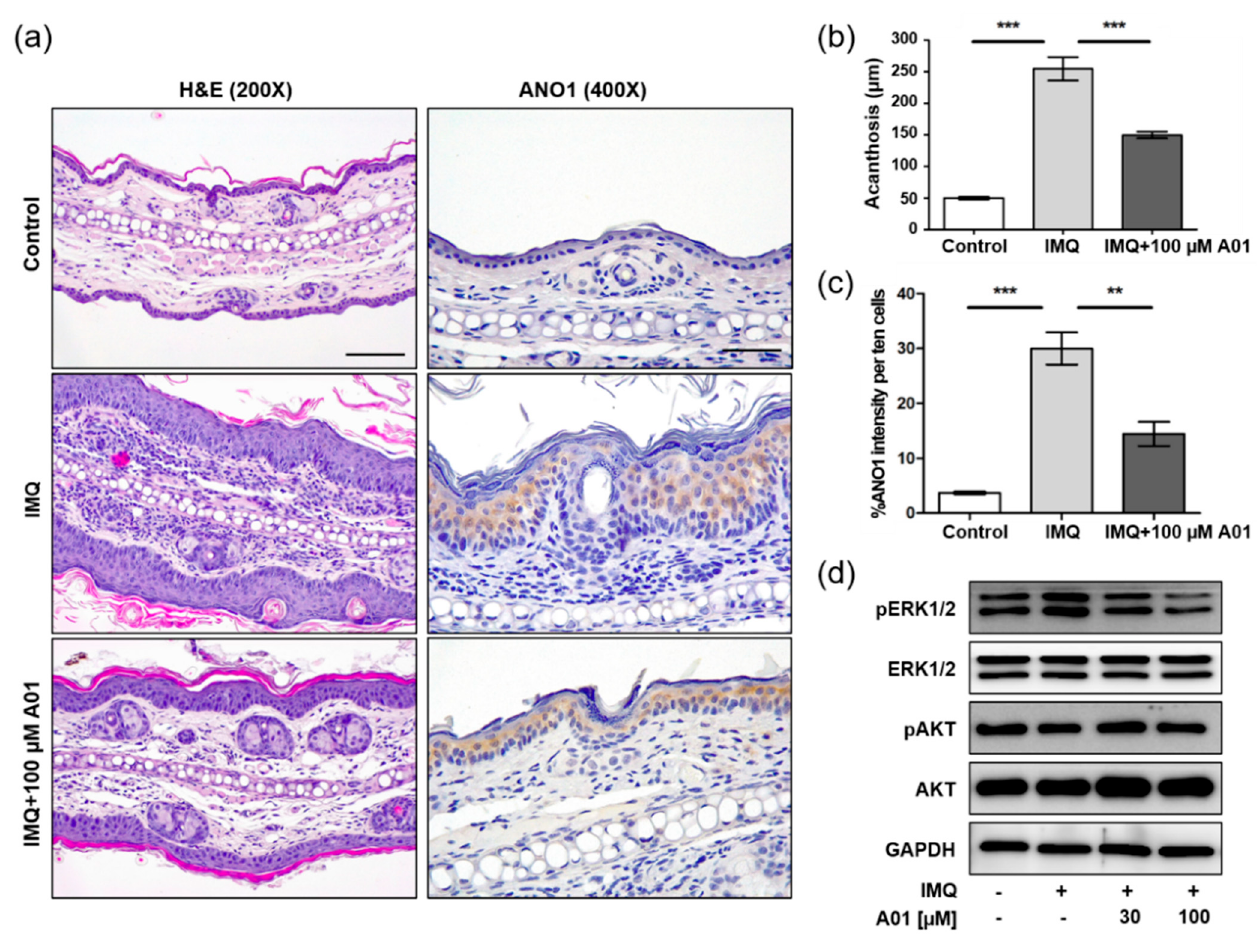
Figure 5. Changes in histopathological structure and ANO1-related proteins in mouse ears showing psoriasis-like symptoms caused by inhibiting ANO1. The right ears of the mice in all four groups (control, IMQ, IMQ + 30 µM A01, and IMQ + 100 µM A01 groups) were obtained on the eighth day after psoriasis-like skin injury and inhibition of ANO1. ( a ) H&E staining and ANO1 immunoreaction in the right ears of control, IMQ, and IMQ + 100 µM A01 groups. Scale bar = 500 µm. ( b ) The quantification of acanthosis in the right ears of control ( n = 3), IMQ ( n = 3), and IMQ + 100 µM A01 ( n = 3) groups. ( c ) The signal intensity of ANO1 per ten cells in the epidermis of right ears of control ( n = 3), IMQ ( n = 3), and IMQ + 100 µM A01 ( n = 3) groups. Significant differences of acanthosis ( b ) or ANO1 intensity ( c ) among control, IMQ, and IMQ + 100 µM A01 groups were analyzed using one-way ANOVA followed by Tukey’s multiple comparison test. *: significantly different from IMQ group (** p < 0.01 and *** p < 0.001). ( d ) The expression levels of ERK and AKT proteins. The phosphorylation of ERK was increased by IMQ cream but was decreased by A01 in a dose-dependent manner. Imiquimod, IMQ; T16Ainh-A01, A01.